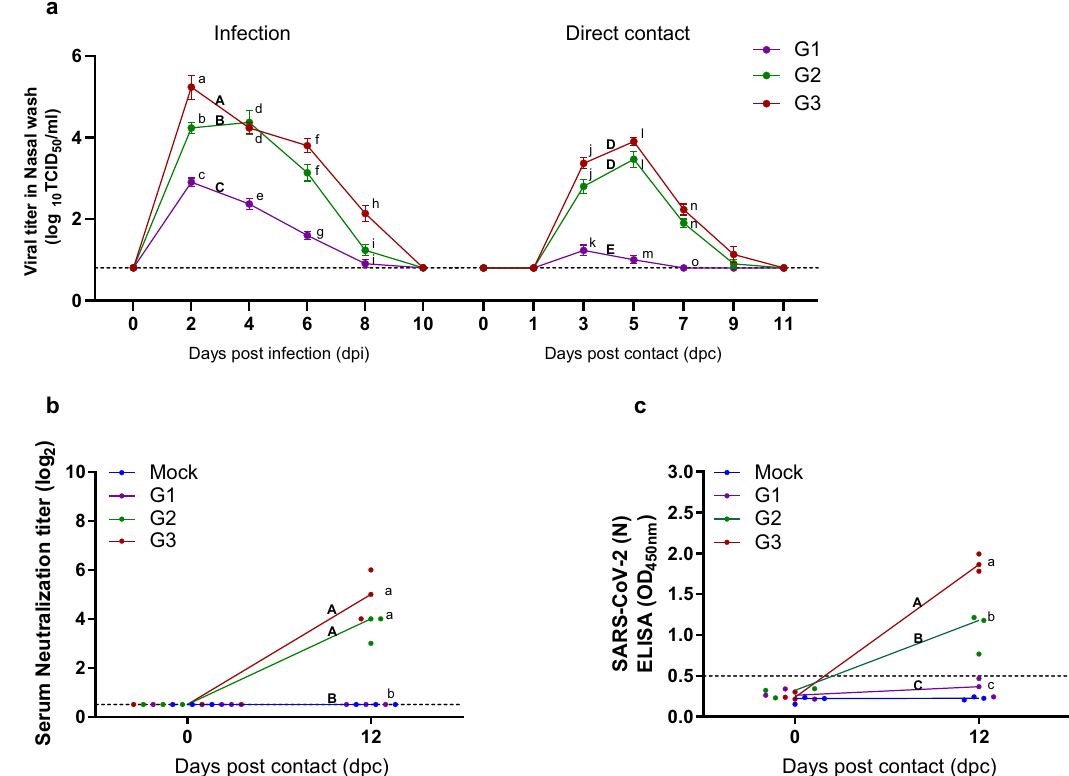
Fig. 5 Transmission properties of SARS-CoV-2 in ferrets of different ages upon co-housing naïve ferrets. Naïve ferrets ( n = 3/group) were exposed to direct contact (DC) with each group of infected ferrets of different ages ( n = 3/group) starting 24 h after the primary infection, followed by measurement of their viral titers from nasal washes on day 1, 3, 5, 7, 9, and 11 post contact ( a ). Serum neutralizing antibody titers in contact groups at 12 dpc ( b ). IgG titers in contact groups at 12 dpc ( c ). Data are presented as mean values± SEM. Groups with the same letter are of the same subgroup in the post-hoc analysis. Lower case letters indicate signi fi cant differences at each time point ( P values are a vs b: 0.00897, a vs c: 0.00046, b vs c: 0.03398, d vs e: 0.0013 or 0.0019, f vs g: 0.00175 or 0.00024, h vs i: 0.0036 or 0.0171, j vs k: 0.00088 or 0.00015, l vs m: <0.0001 and n vs o- 0.00058 or 0.00013 ( a ), a vs b: 0.0009 or <0.0001 ( b ), a vs b: 0.0031, a vs c: <0.0001 and b vs c: 0.0053 ( c )), while upper case letters indicate signi fi cant differences of area under the curve as change over the entire period ( P values are A vs B: 0.00844, A vs C: < 0.0001, B vs C: 0.00014 and D vs E: 0.0001 or <0.0001 ( a ), A vs